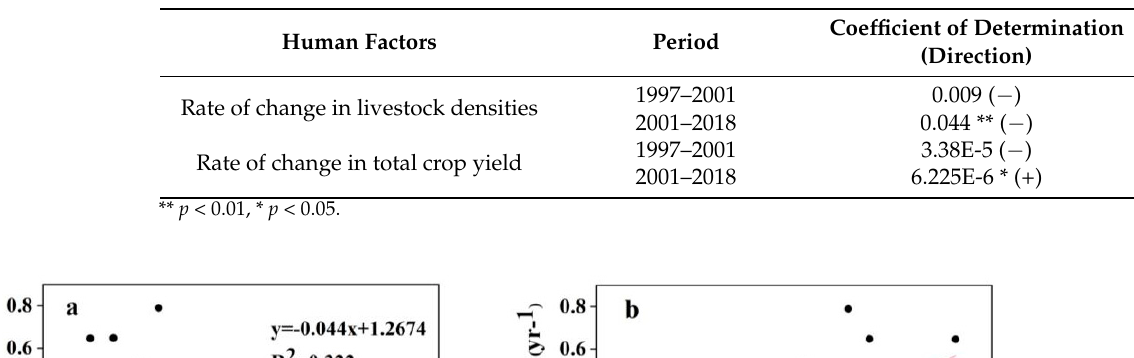
Table 3. Coefficients of determination and directions of regression between NDVI residual trend and rate of change in livestock densities and rate of change in total crop yields for 1997–2001 and 2001–2018.